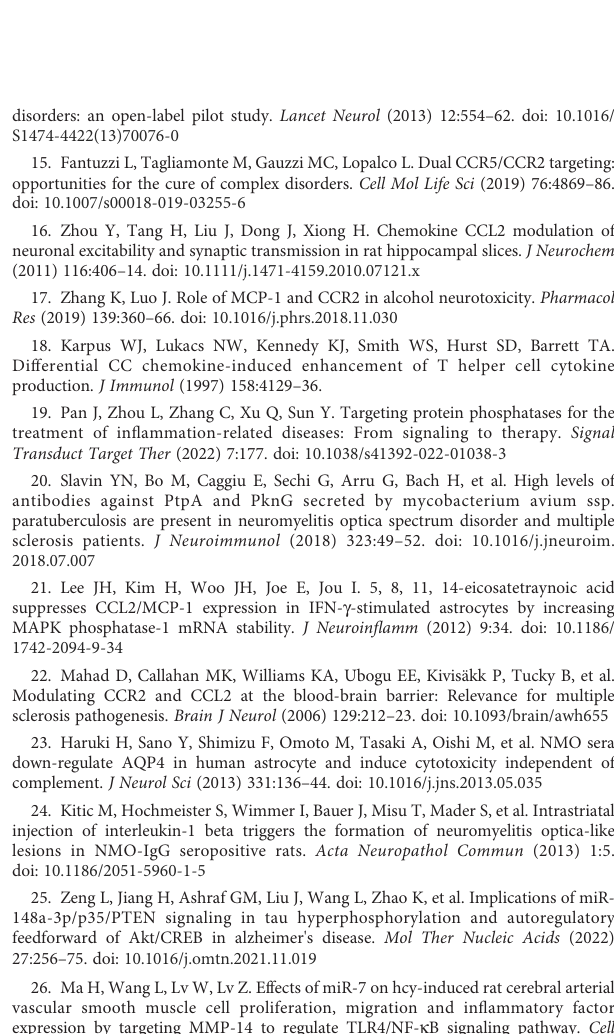
SUPPLEMENTARY FIGURE 3 Proportion comparison of different monocyte subsets sorted by fl ow cytometry from NMOSD patients in the relapse or remission